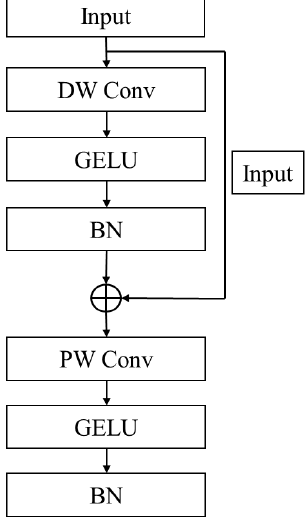
Figure 8. Overall structure of Light-Unit. Table 2. Specific parameters of Light-Unit.